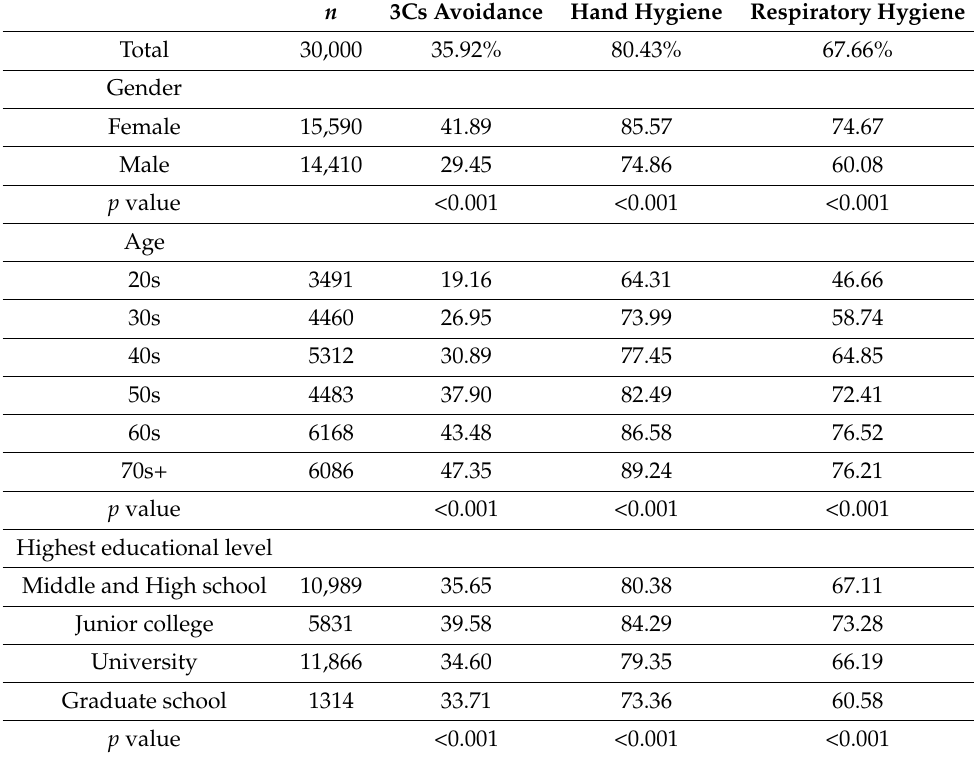
Table 1. Sociodemographic characteristics of the respondents by adoption of preventive